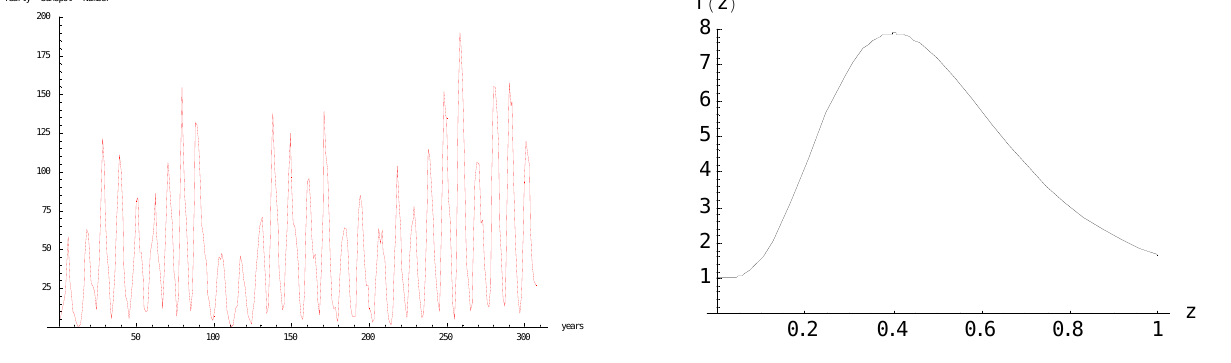
Fig. 2. Pulse shape of a spot cycle modelled by Eq. (2) with pa- rameters α k = 10 , ε = 1. This parametric representation can fit fairly well the overall envelope of one solar cycle, using a restricted set of parameter